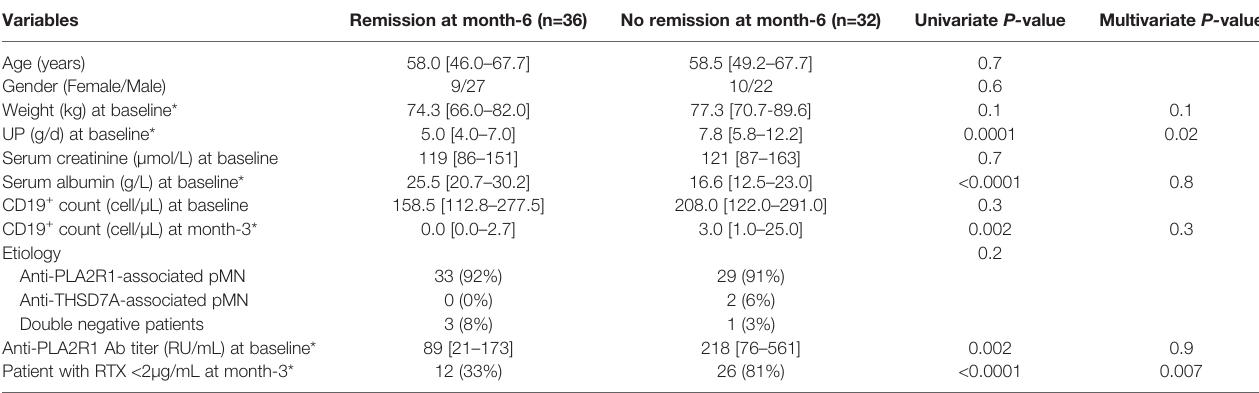
TABLE 2 | Univariate and multivariate analysis of variables associated with clinical remission at month-6. Variables Remission at month-6 (n=36) No remission at month-6 (n=32) Univariate P-